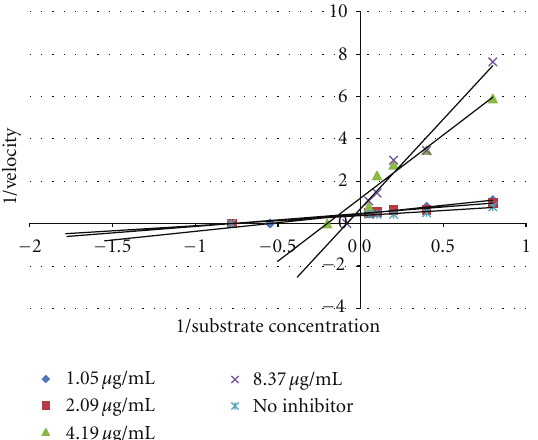
Figure 3: Lineweaver-Burke plot of the reaction α -glucosidase in the presence of 80% ethanol extract from Amaracarpus pubescens